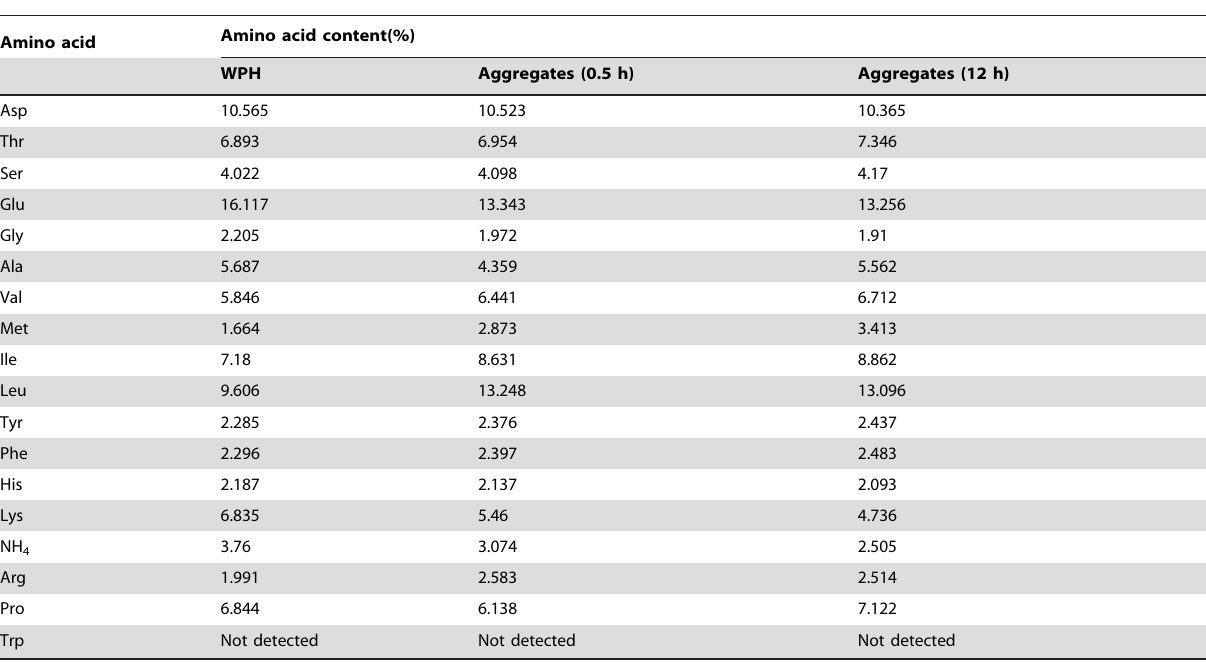
Table 1. Amino acid composition of WPH and aggregates (incubated for 0.5 or 12 h).